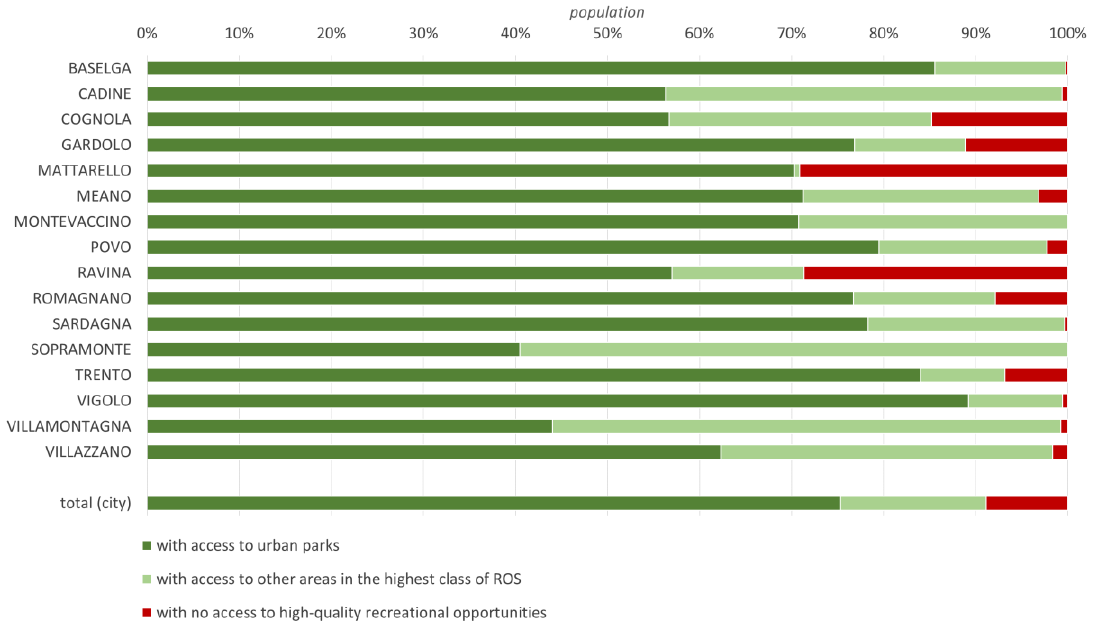
Figure 8. Share of population with access to urban parks and to other areas in the highest class of